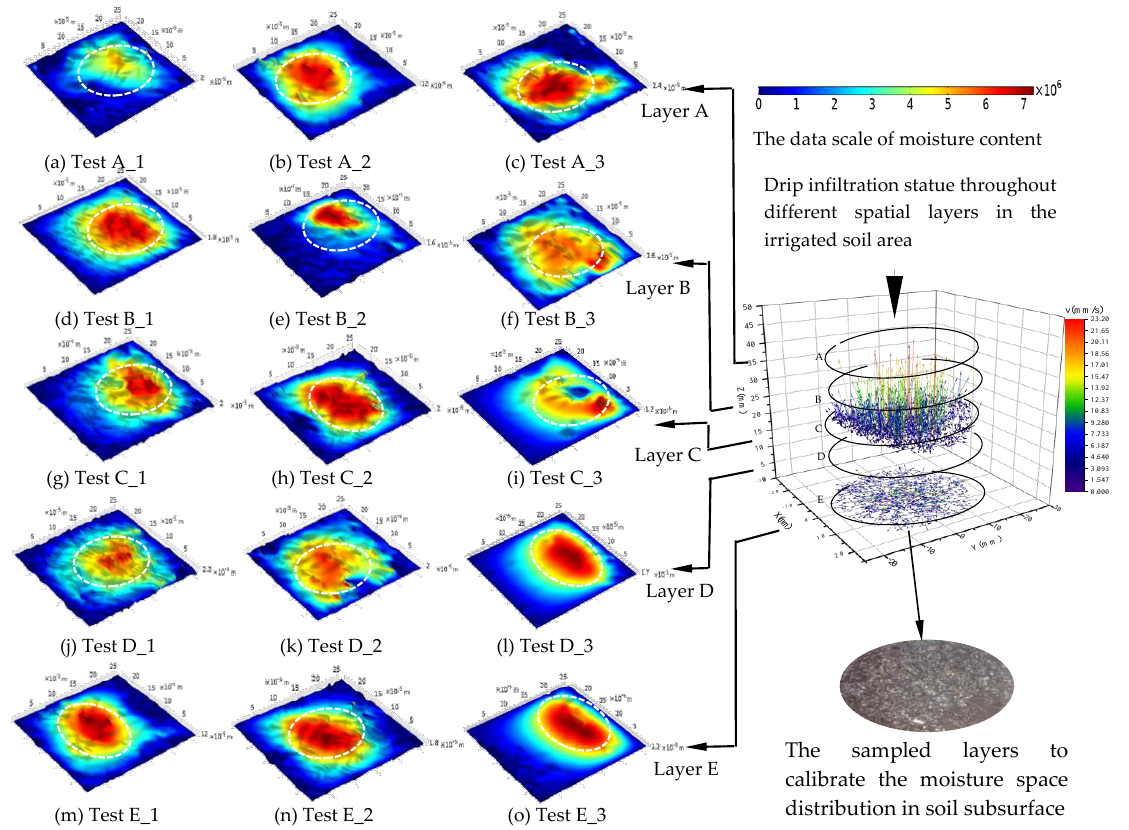
Figure 3. Data illustration of drip infiltration considering the moisture space distribution labeled as sampled layer A.